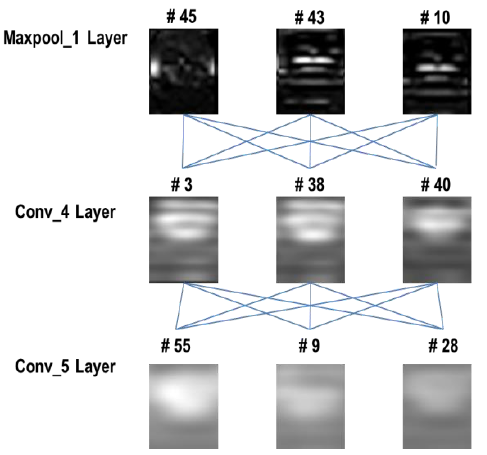
Figure 14. Feature map combinations.